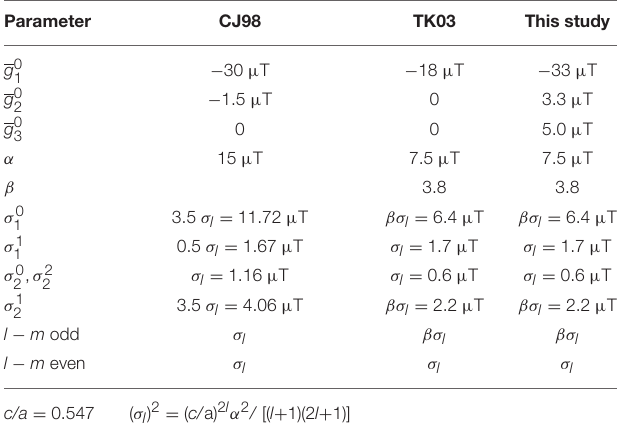
TABLE 1 | Parameters for secular variation models considered in this paper. CJ98 is from Constable and Johnson (1999)and TK03 refers to Tauxe and Kent (2004). Parameter CJ98 TK03 This study